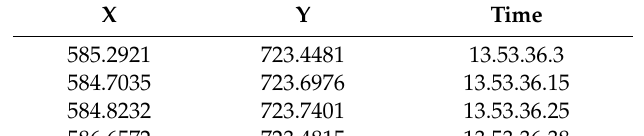
Table 5. Example of CSV eye-tracking data.